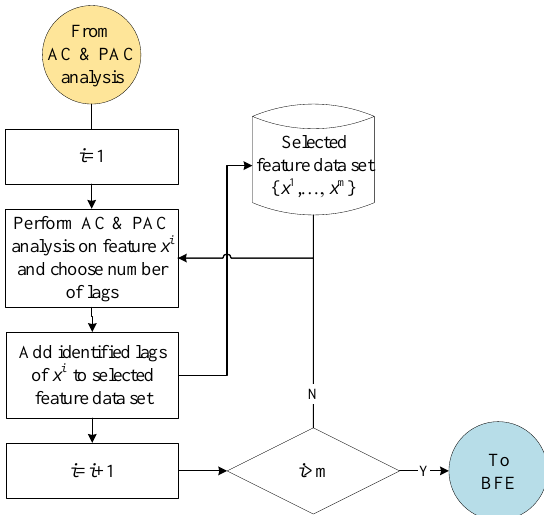
Figure 8. Autocorrelation and partial autocorrelation sub-process.